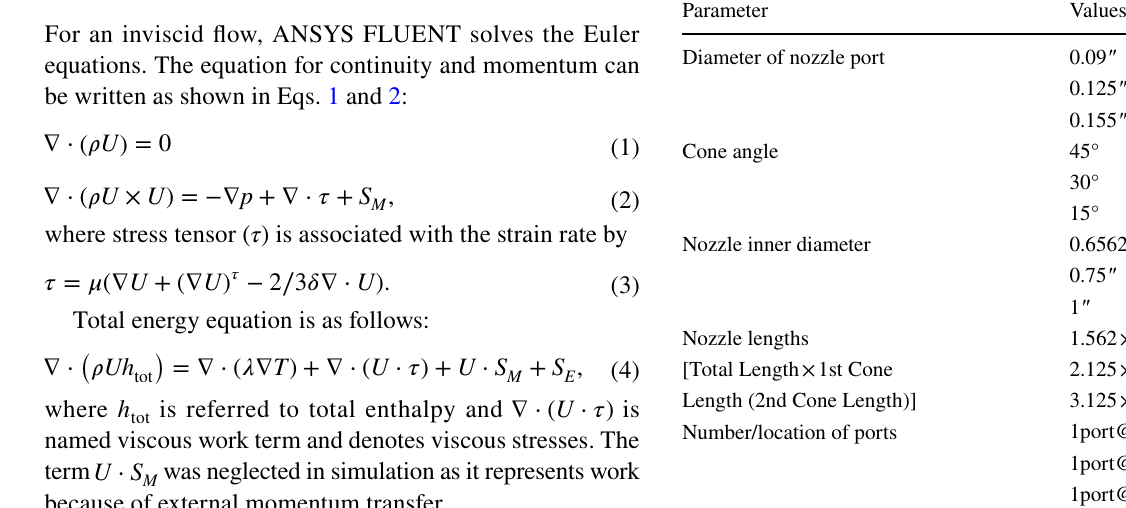
Table 3 Parameters used to set up various design configurations